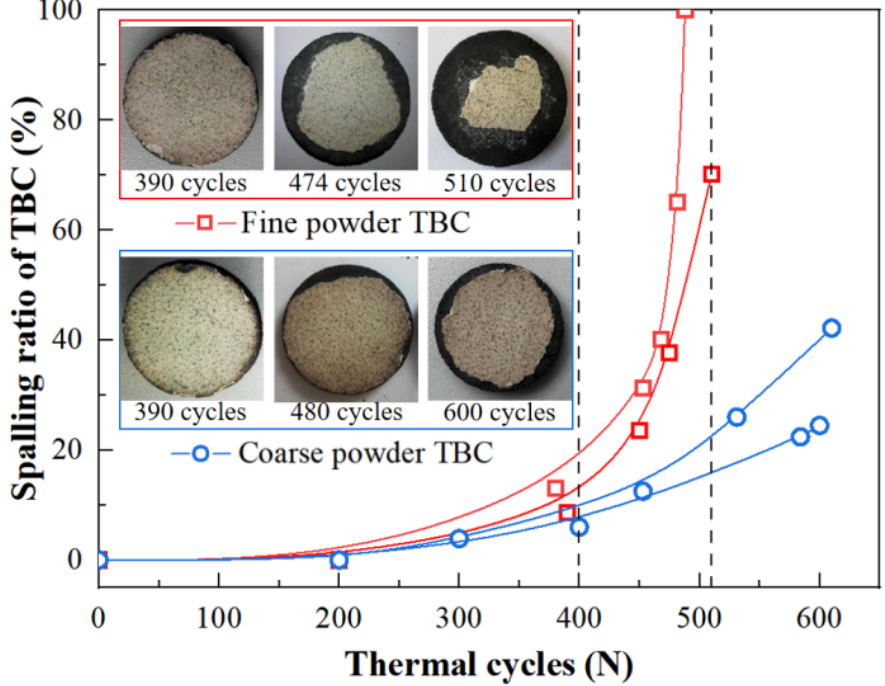
Figure 7. Evolution of macroscopic morphology and spalling ratio of the two kinds of TBCs during thermal cycling.